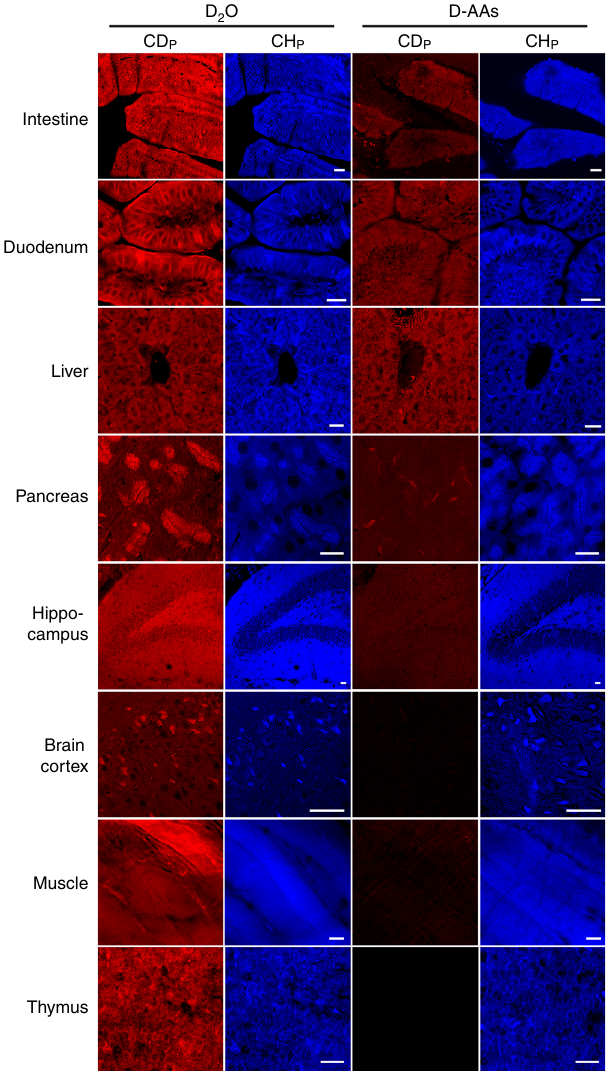
Fig. 6 DO-SRS microscopy enables tracking of in vivo protein synthesis with high ef fi ciency and without tissue bias. A variety of protein-rich organs were collected from adult mice that were administrated with 25% D 2 O or 2 mg ml − 1 of D-labeled amino acids (D-AAs) in drinking water for 8 days and then imaged for CD P and CH P signals. Scale bar = 20 μ